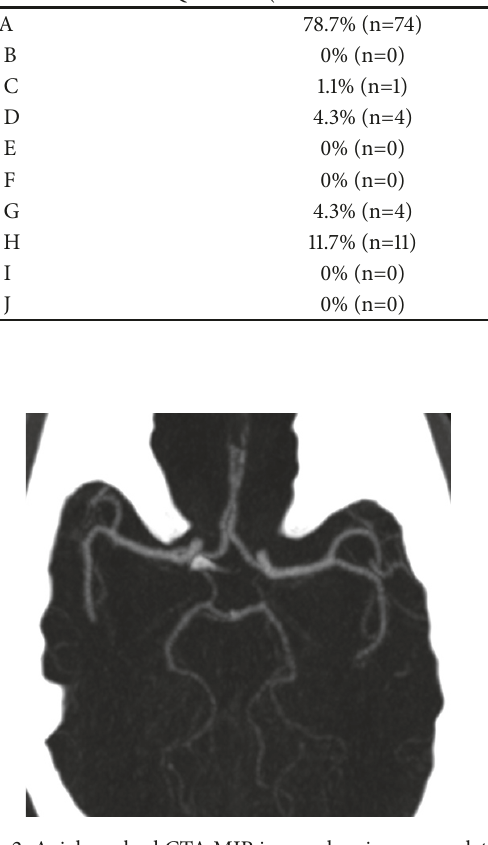
Figure 2: Axial cerebral CTA MIP image showing a complete CW configuration.